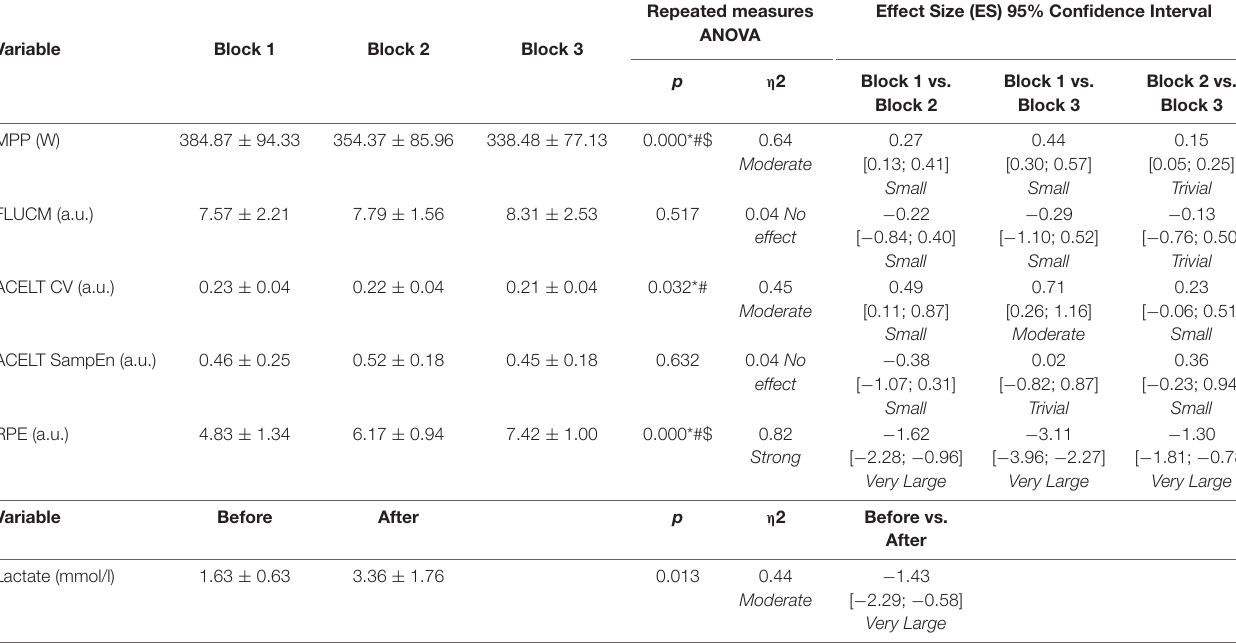
TABLE 4 | Between-blocks comparisons in the mechanical and perceptual variables – Parallel Back Squat.